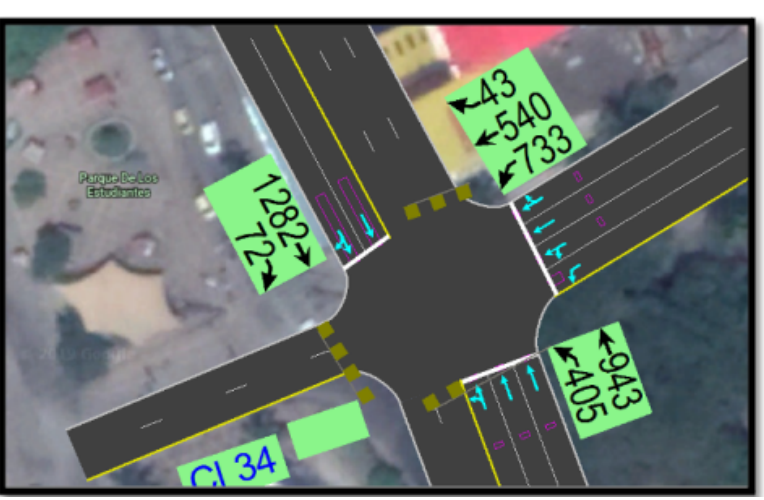
Figure 11: Traffic flow and allowed turns simulation for Intersection